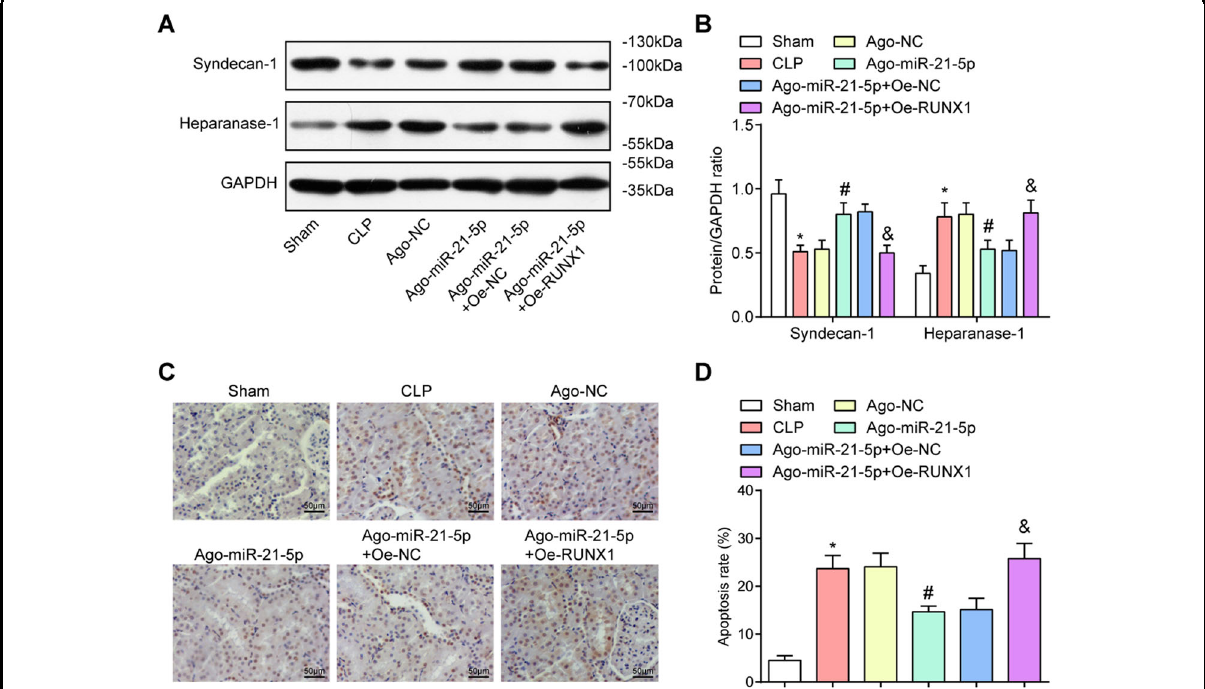
Fig. 2 Highly expressed miR-21-5p increases syndecan-1 and reduces heparanase-1 expression and apoptosis in renal tissues of CLP rats. A Protein bands of syndecan-1 and heparanase-1 in renal tissues of rats. B Comparison of syndecan-1 and heparanase-1 protein contents in renal tissues of rats. C TUNEL staining was used to detect the apoptosis of rat renal cells (scale bar = 50 μ m). D Comparison of renal cell apoptosis rate in CLP rats. n = 10. * P < 0.05 vs. the sham group. # P < 0.05 vs. the Ago-NC group. & P < 0.05 vs. the Ago-miR-21-5p + Oe-NC group. Measurement data were depicted as mean ± standard